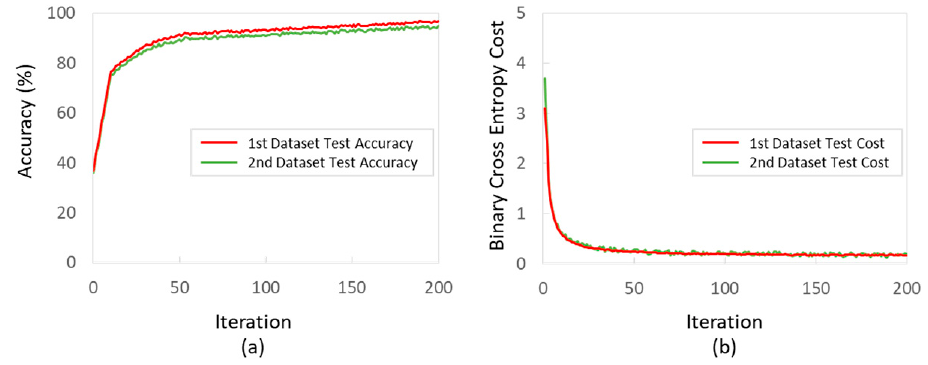
Figure 7. Accuracy and cost of testing using the first and second dataset: ( a ) accuracy (red line for the first data set and green line for the second dataset); and ( b ) binary cross-entropy cost between ground truth and predicted labels for test (red line for the first data set and green line for the second dataset).